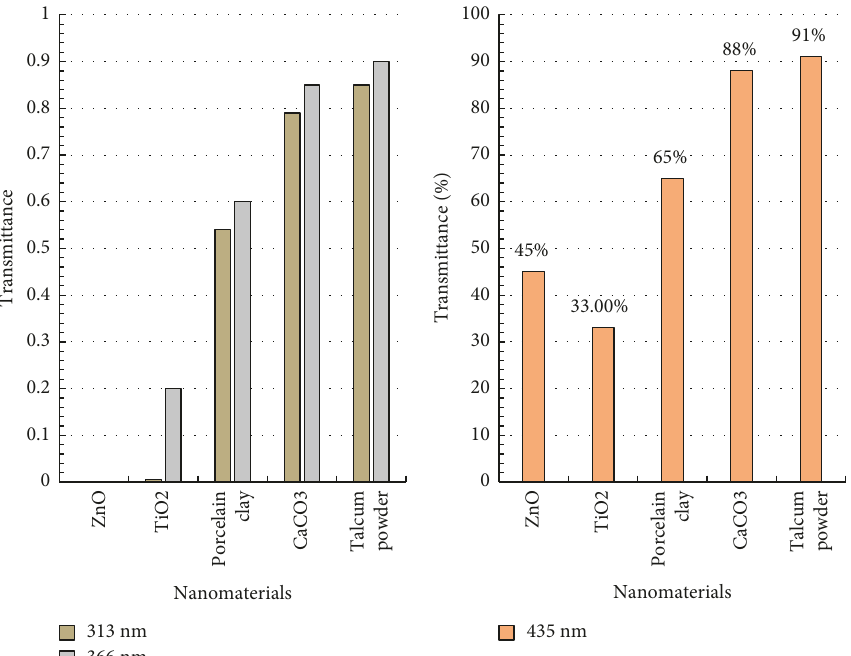
Figure 8: UV transmittance properties of several nanomaterials.